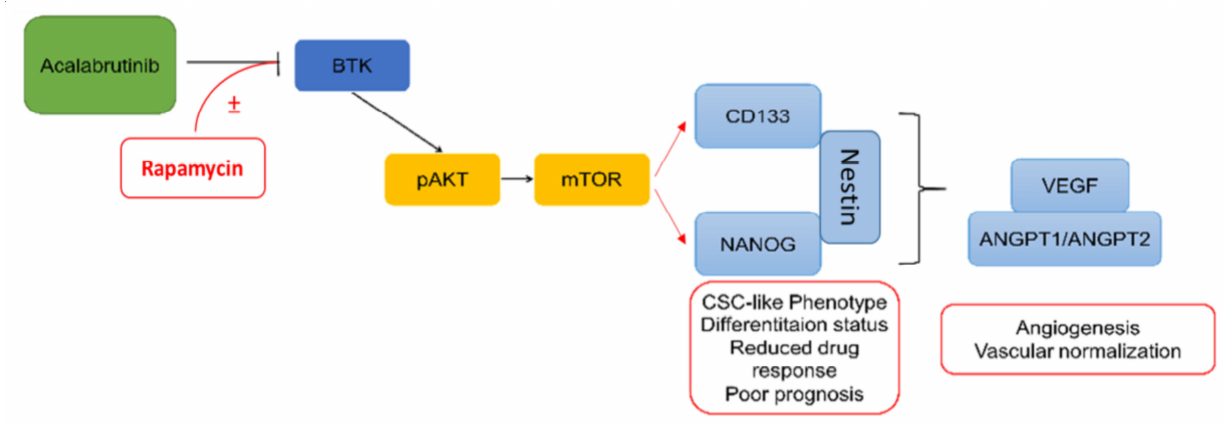
Figure 7. Graphical abstract depicting the synergism between acalabrutinib and rapamycin in attenuating the CSCs properties of GBM, and subsequently reduced angiogenesis and vascular